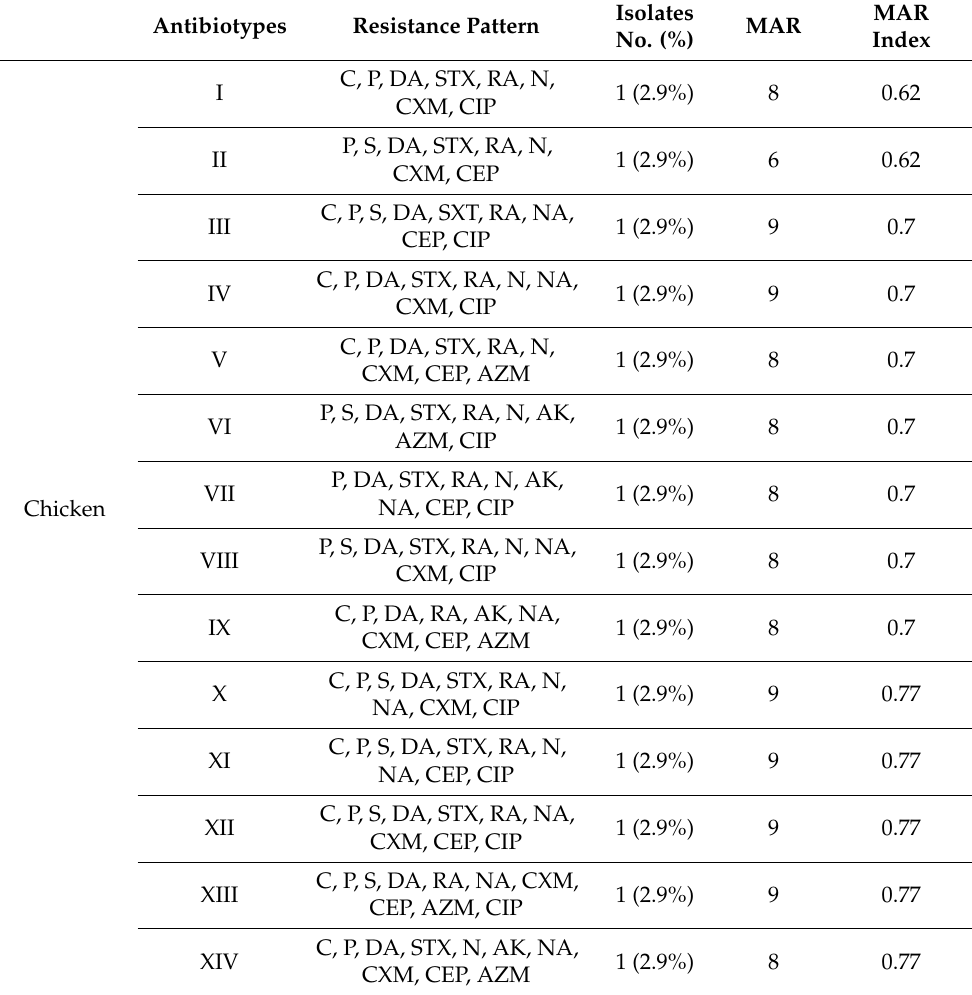
Table 5. Different patterns of antimicrobial susceptibility detected for the E. coli